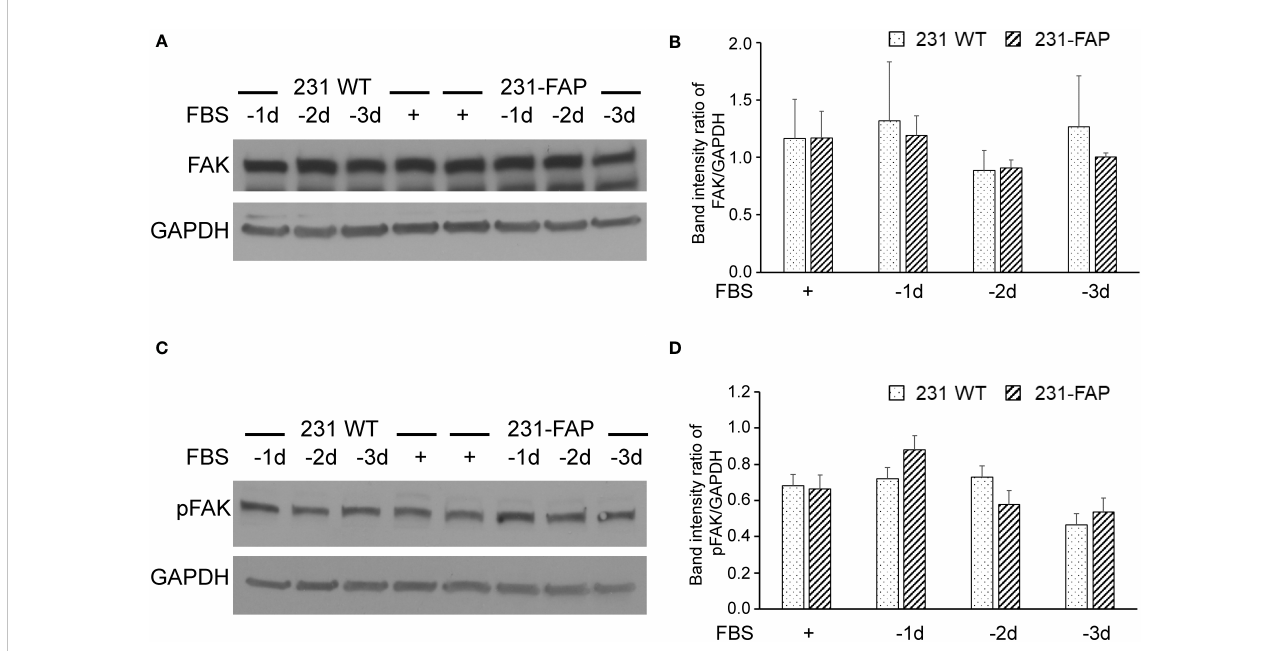
FIGURE 7 Representative immunoblots of (A) focal adhesion kinase (FAK) and (C) phosphorylated FAK (pFAK) with GAPDH used as loading control in 231 WT and 231-FAP cells cultured with (+) or without (-) FBS. Quantitative immunoblot analysis represented as band intensity ratio of (B) FAK (n = 2-3) and (D) pFAK (n = 3) to GAPDH, normalized to 231 WT FBS+ values. -1d: 1 day without FBS. Values represent Mean ±